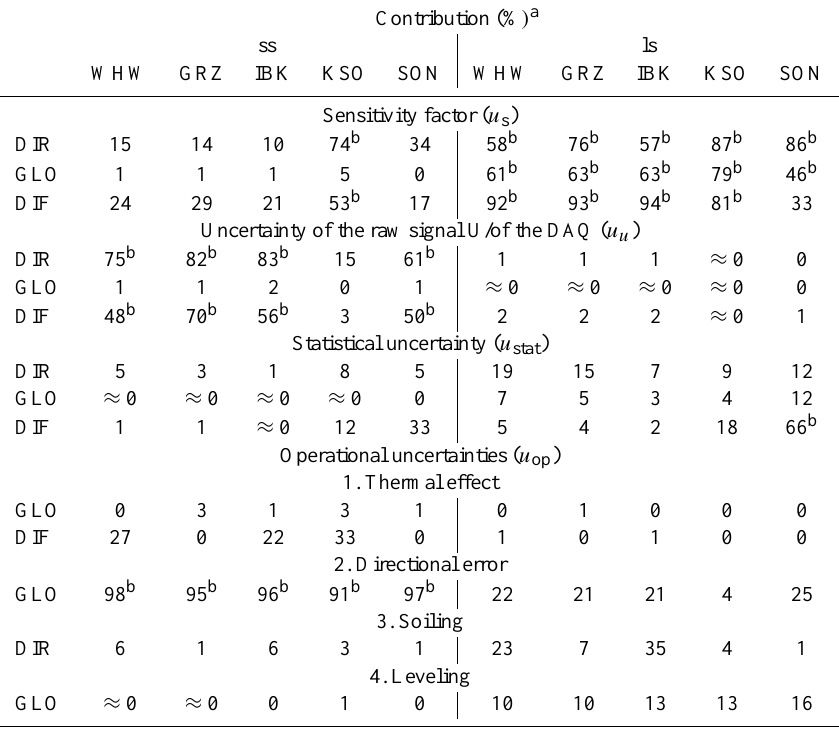
Table 5. Same as Table 4 but relative contributions of uncertainty components to total combined uncertainty. Uncertainties are given for a small (ss: 50Wm − 2 ) and a large (ls: 500Wm − 2 for DIF and 1000Wm − 2 for DIR and GLO)